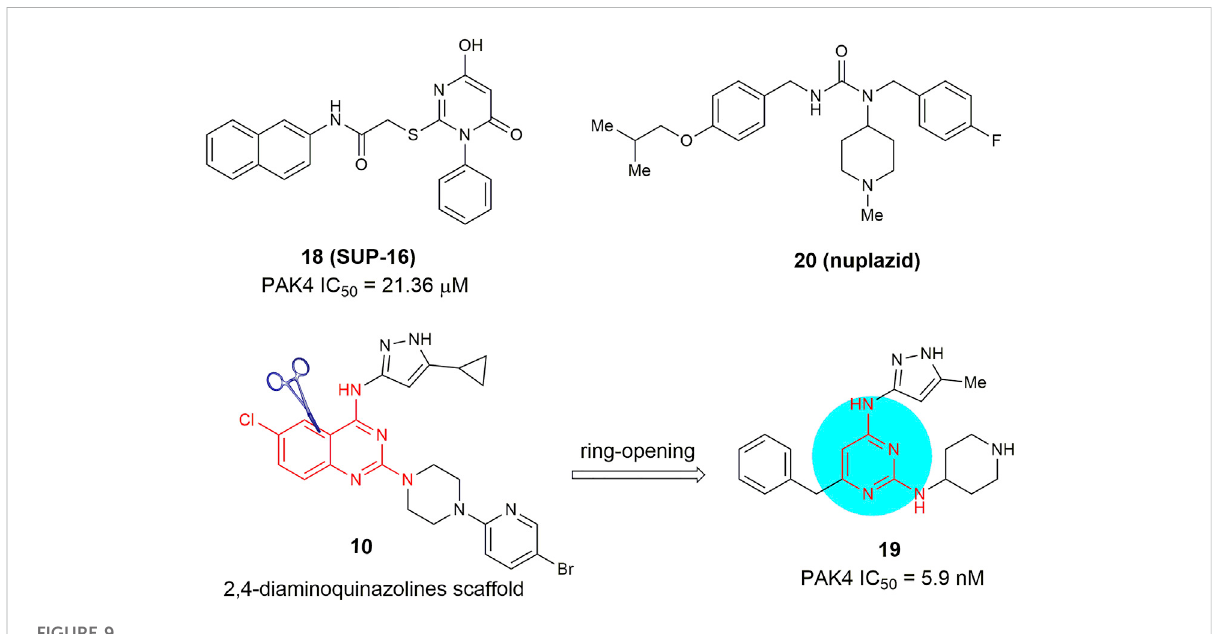
FIGURE 9 Monocyclic PAK4 inhibitors 18 –